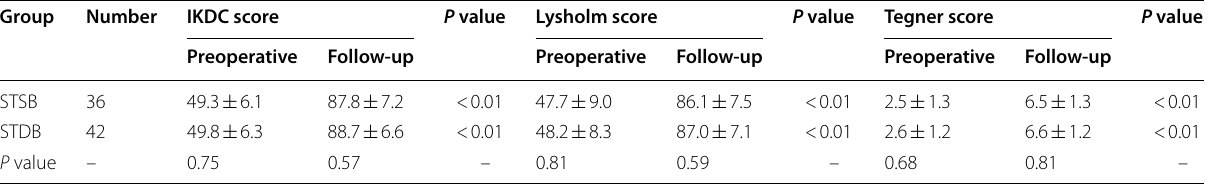
The Mann–Whitney U rank test was used